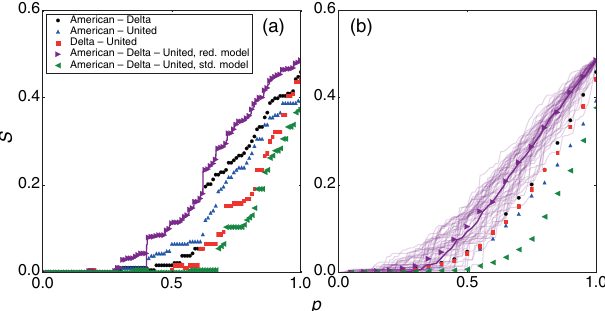
FIG. 2. Percolation transition in the US air transportation network [39]. We consider only US domestic flights operated in January 2014 by the three major carriers in the US (American Airlines, Delta, and United), and we construct a multiplex network where airports are nodes, and connections on the layers are determined by the existence of at least one flight operated by a given carrier between the two locations. The number of nodes in the network is N ¼ 183 . Please note that some of the nodes appear as connected only in one layer; therefore, the relative size of the largest cluster is always smaller than one. (a) We consider a single realization of the random damage by assigning to every replica node ð i; α Þ a random number extracted uniformly in the interval [0, 1]. Replica nodes are considered damaged if their associated random number is smaller than p . Note that the same exact configuration of random damage is considered in all cases. In the percolation diagram, we consider the size of the MCGC and RMCGC as a function of p . Large symbols are results of numerical simulations, whereas the tick line is obtained from the solution of our mathematical framework [system of Eqs. (1) – (4)]. In particular, we consider the three possible multiplex networks composed of only two layers: American – Delta (black circles), American – United (blue triangles), and Delta – United (red squares). Diagrams obtained by considering the system as composed of all three layers are represented as green triangles for the model of Ref. [4] and as purple triangles for the redundant model. (b) Same as in panel (a) but for average values over 100 independent realizations of the random damage. Purple thin lines stand for the 100 independent realizations of random damage considered in the case of the redundant model. As is apparent from the figure, the average does not capture the behavior of single instances of disorder well, and fluctuations are rather large for a wide range of possible values of p